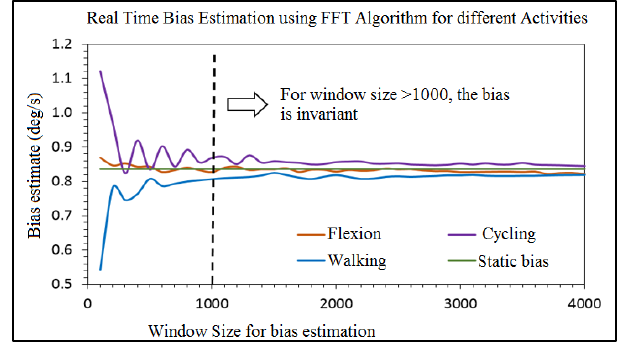
Figure 5 Sensitivity of estimated bias to sample window size